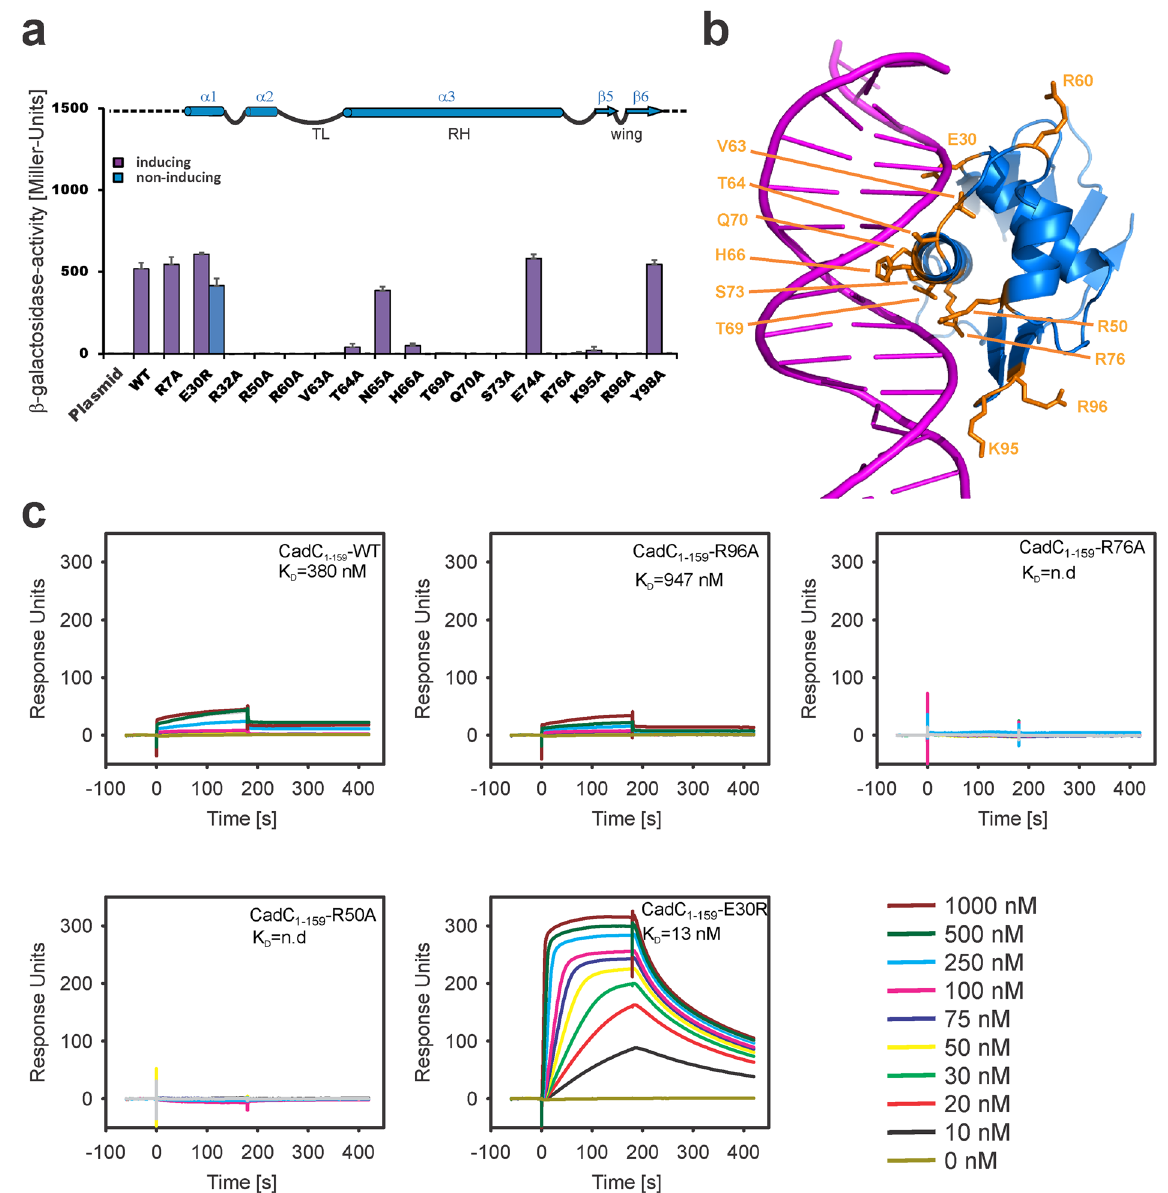
Figure 5. Influence of amino acid substitutions within CadC on the expression of the cadBA operon. ( a ) Quantification of cadBA transcription in E. coli EP314 using the reporter gene lacZ . Cells were grown at inducing or non-inducing conditions, and the β -galactosidase activity was determined. The experiment was performed in triplicate, and error bars indicate standard deviations from the means. On top, a part of the CadC secondary structure is shown to give orientation along the elements that are essential for transcriptional regulation. See Supplementary Fig. S5 for all tested experimental conditions. ( b ) Visualization of mutation sites within CadC 1-107 . The structure shows the CadC DBD docked to pho -box DNA as in Fig. 1d. Selected side chains from amino acids with significant effect in ( a ) and from CSPs in Fig. 4c are shown as sticks and annotated. ( c ) CadC affinity for Cad1 41-mer DNA. Representative SPR sensorgrams obtained from CadC 1-159 wild-type (WT) or the respective variants injected in different concentrations (see colour code) to immobilized Cad1 41-mer DNA. Sensorgrams representing real time binding are shown with steady-state dissociation constants. The figures represent each one characteristic of three independently performed experiments. Binding curves to derive the overall steady-state affinities are shown in Supplementary Fig.